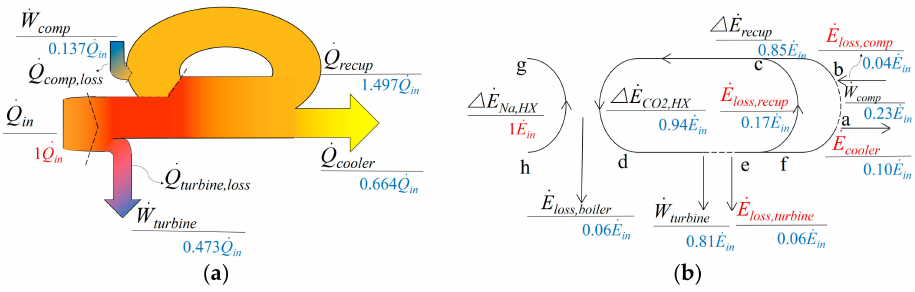
Figure 3. Energy and exergy distributions of the recuperation cycle [25]. ( a ) Heat and power, ( b ) Exergy and exergy loss. A–h represent state points of working fluid in the